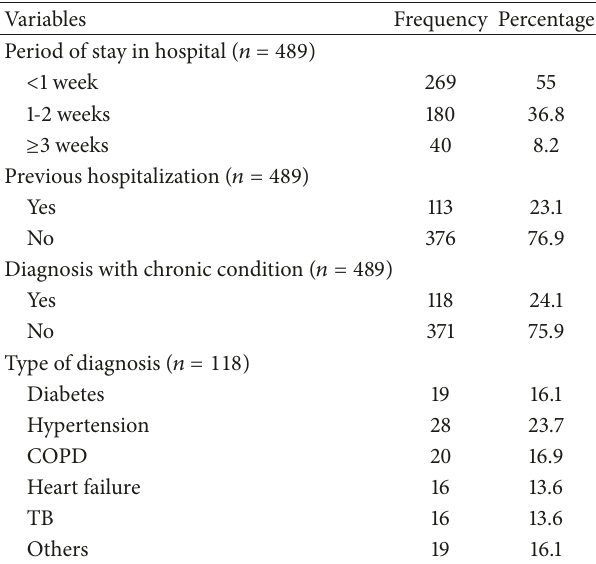
Table 2: History of hospitalization and diagnoses related factors of respondents on depression and associated factors among adult inpatients in Harari region hospitals, Eastern Ethiopia, 2017.